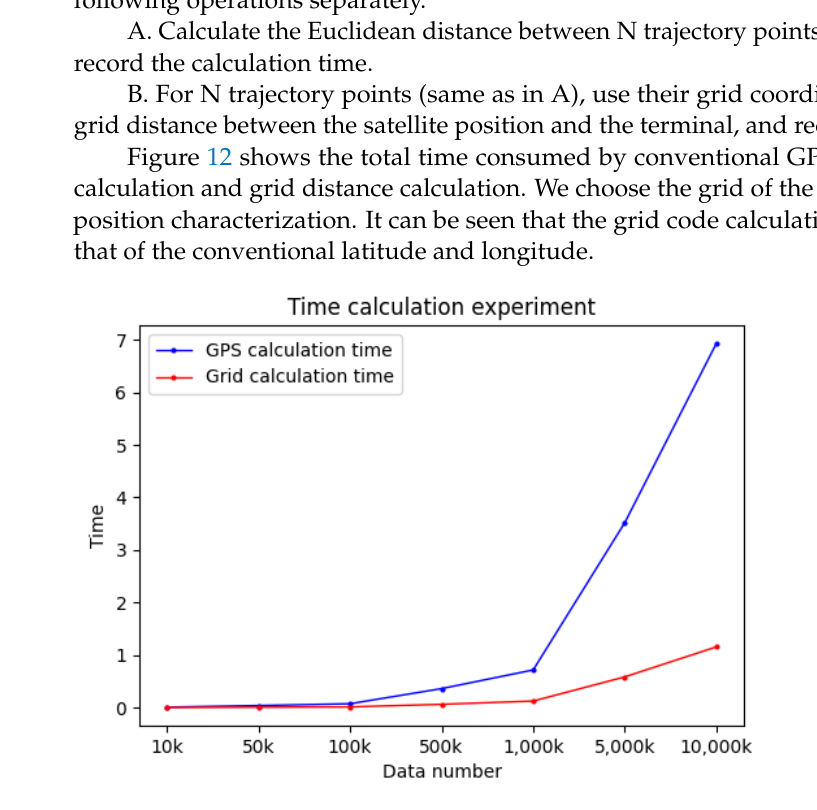
Figure 11. Impact of maximum angle on grid calculation.